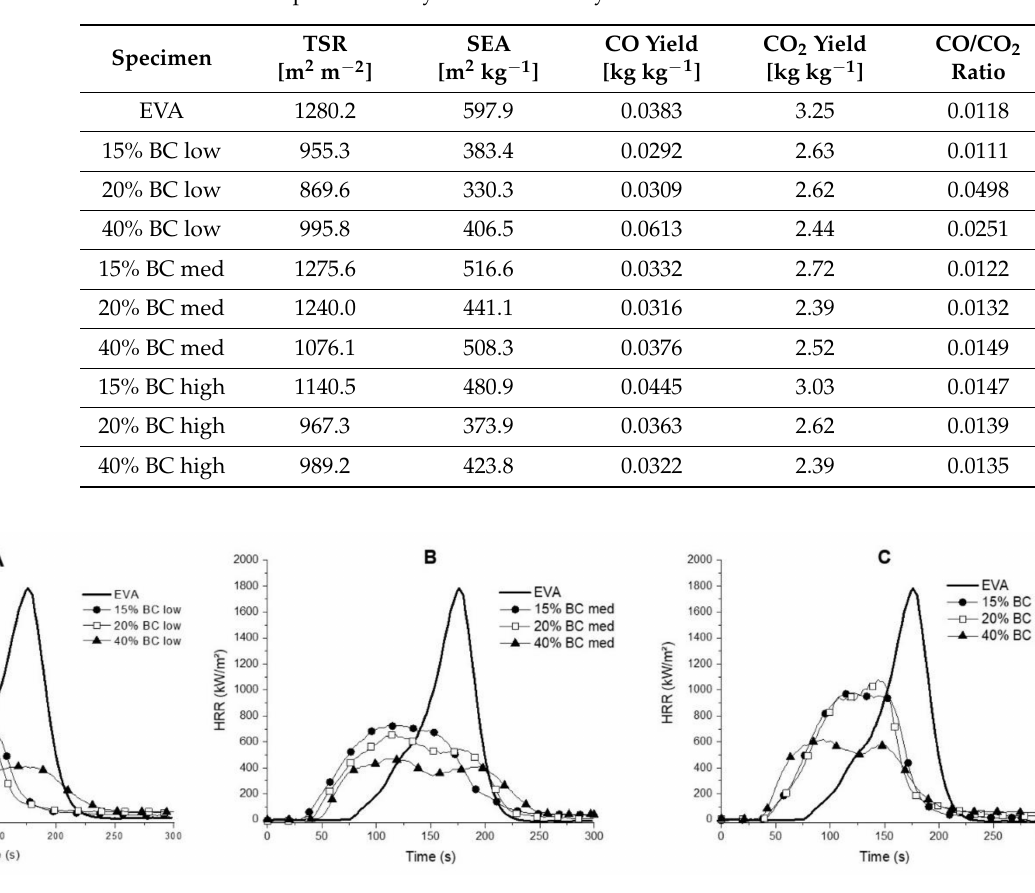
Figure 6. HRR vs. time cone calorimetry curves of EVA and its compounds: EVA BC low ( A ); EVA BC med ( B ); and EVA BC high ( C